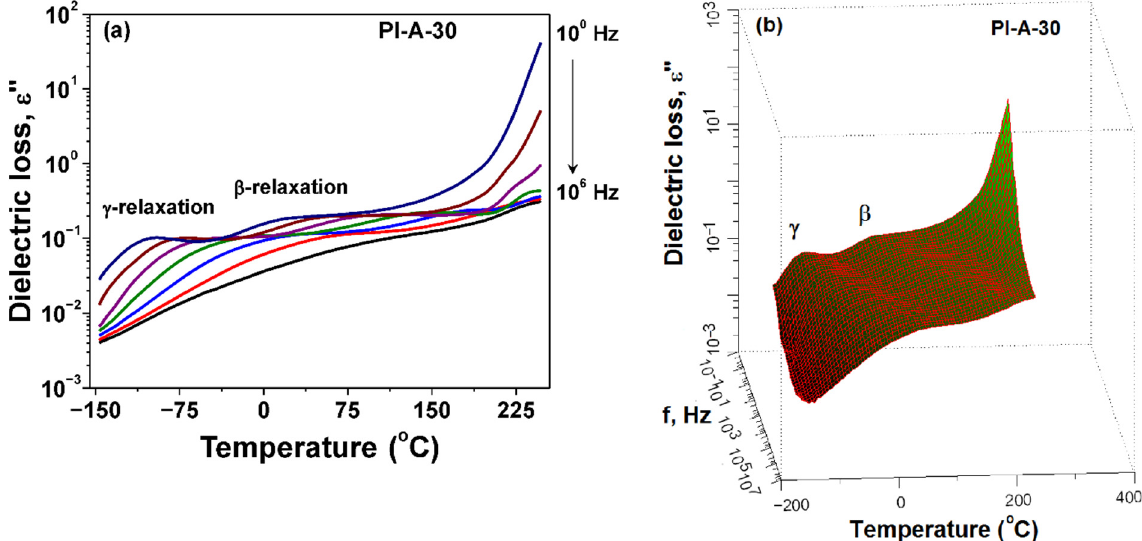
Figure 7. Dielectric loss evolution with temperature at selected frequencies ( a ) and 3D presentation of ε ″ as function of frequency and temperature ( b ) for PI-A-30.